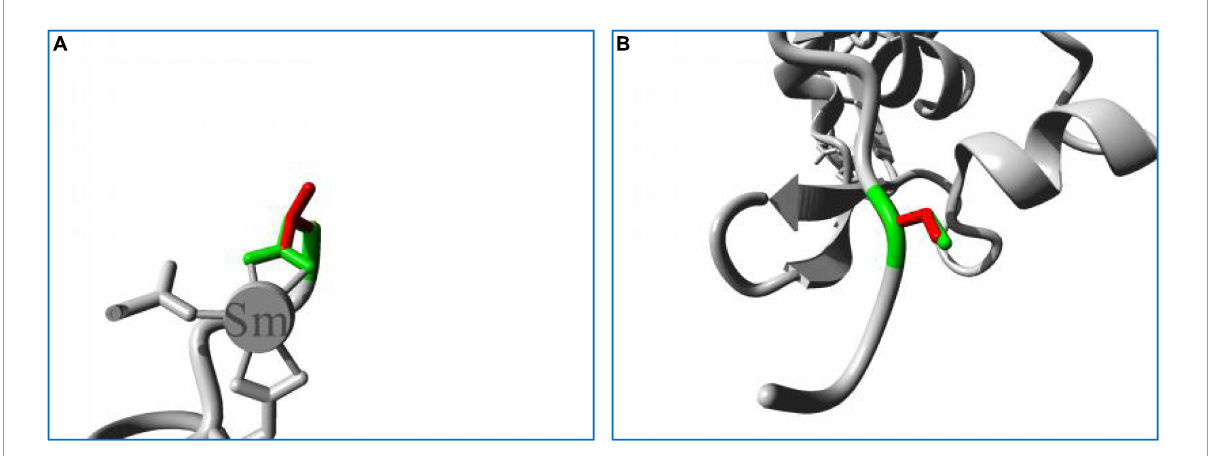
FIGURE5 Close-up image of the superimposed structures of wild-type and mutant residues. (A) Asp723Val. (B) Cys1687Ser. The protein core is shown in gray, while the amino acid side chains of the wild-type (green) and the mutant (red) residues are represented as